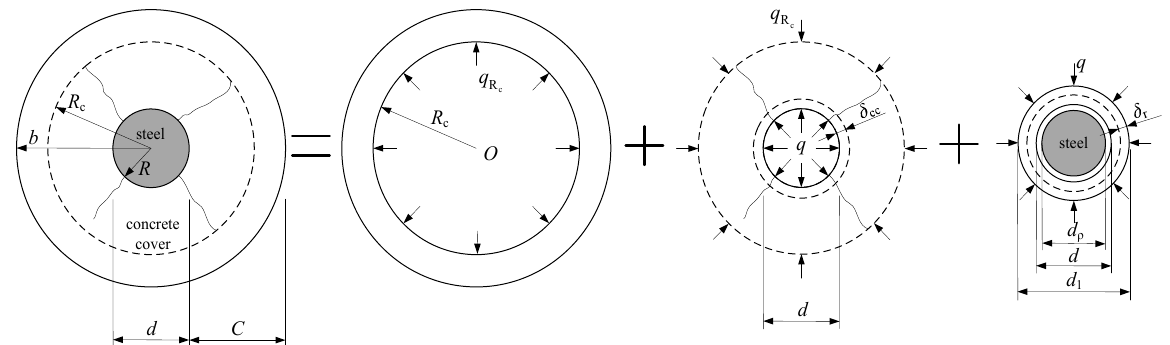
Figure 10. Radial deformations of concrete and rust layers at the IBSC under the total radial pressure in the partial cracking stage of the concrete cover.